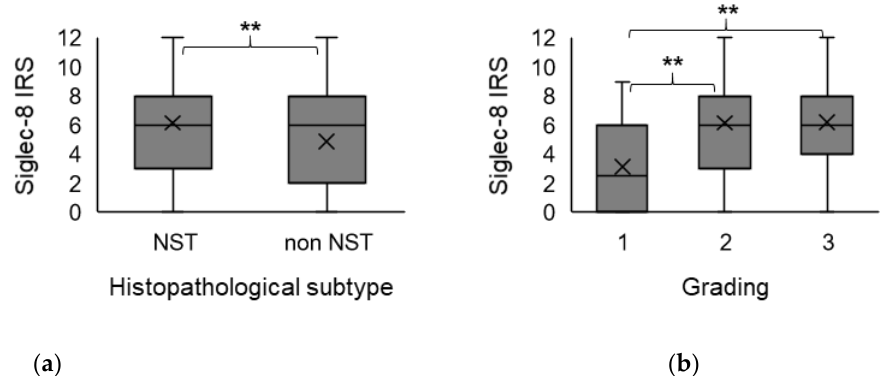
Figure 1. Association of Siglec-8 expression with histopathological subtype and tumor grading. Boxplots of the mean Siglec-8 IRS ± standard deviation (SD) dependent on histopathological subtype ( a ) and tumor grading ( b ) are shown. ( a ) In non-NST tumors, Siglec-8 expression is significantly lower than in NST tumors. ( b ) Tumors with G2/3 grading show a significantly higher Siglec-8 expression compared to G1 tumors. NST = no special type. IRS = immune reactivity score. SD = standard deviation. G = grading. ** indicates a p -value < 0.01.